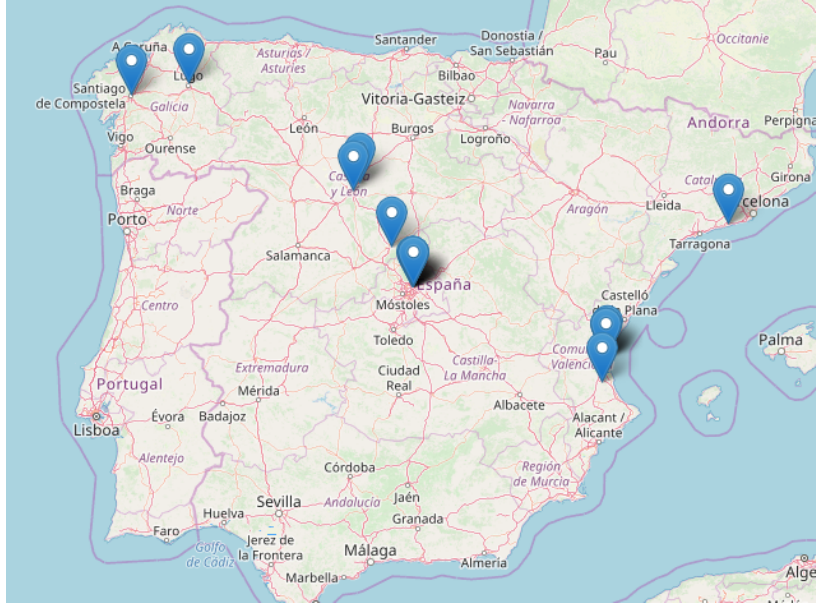
Figure 9. Geographical Distribution of